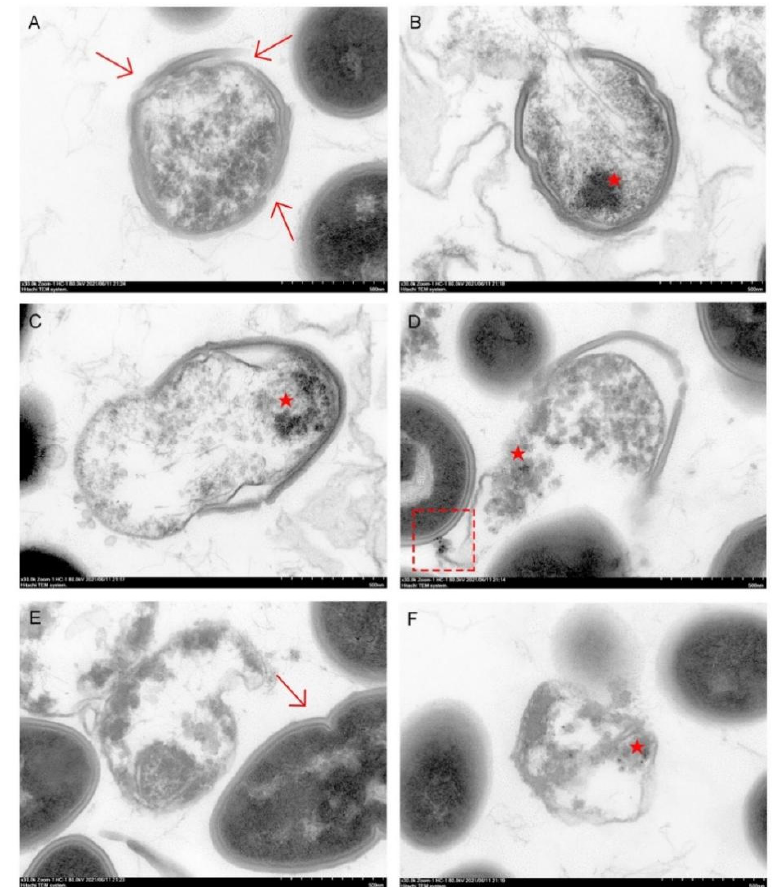
Figure 11. TEM images of endocytosis behavior of E. faecalis after being treated with M-AgTX. ( A – F ) Different degree of biological membrane defect. ( ★ indicating the nanoparticles, arrows in ( A ) indicating the cell membrane defect, square frame in ( D ) indicating the M-AgTX outside the cell, and arrow in ( E ) indicating the normal morphology.